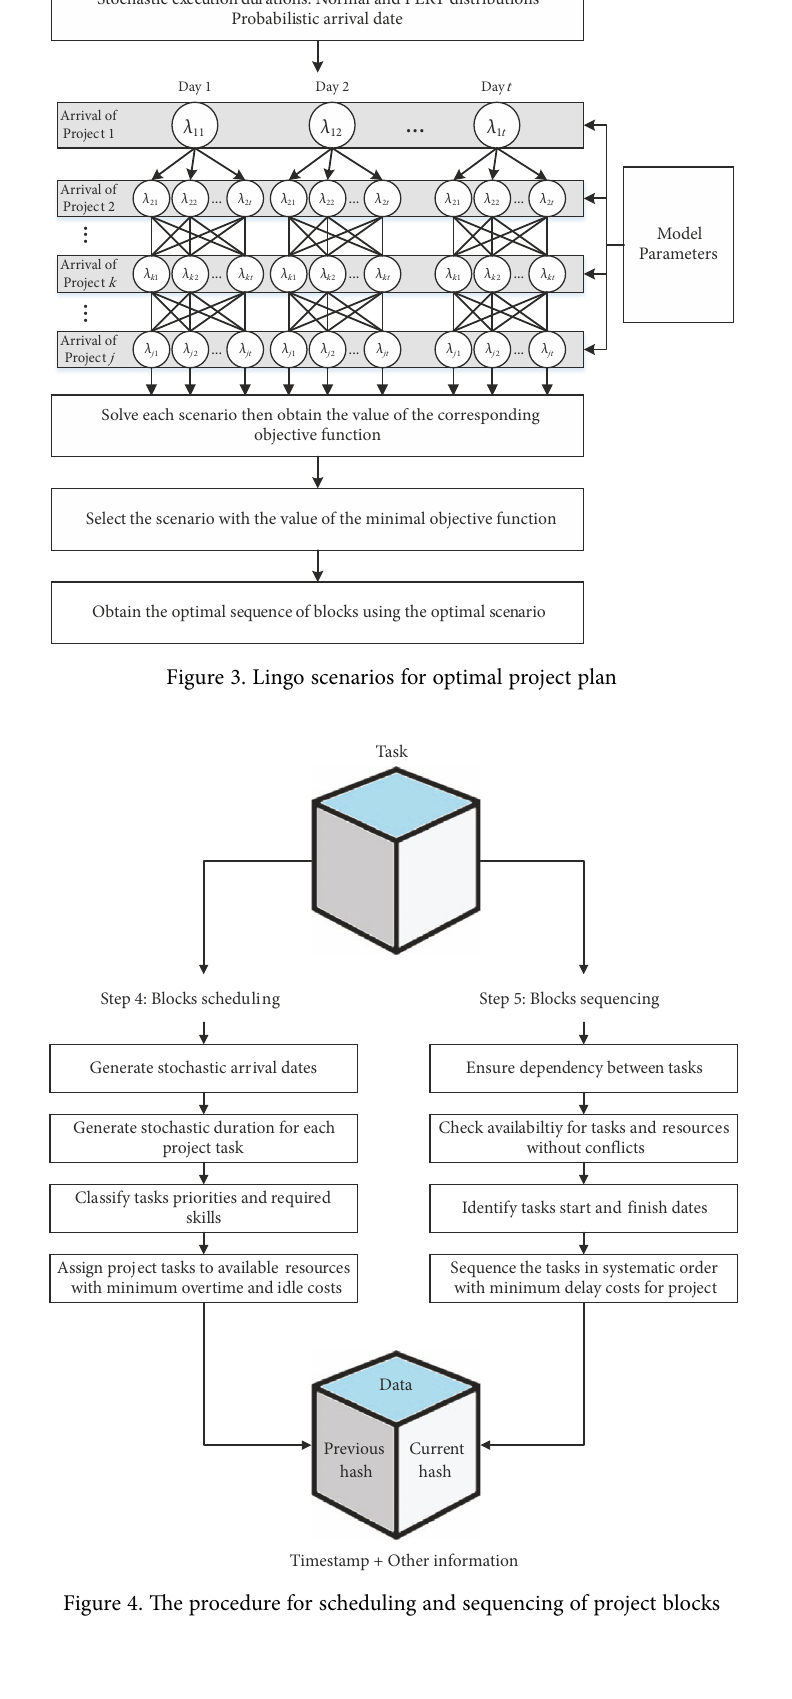
Figure 4. The procedure for scheduling and sequencing of project blocks